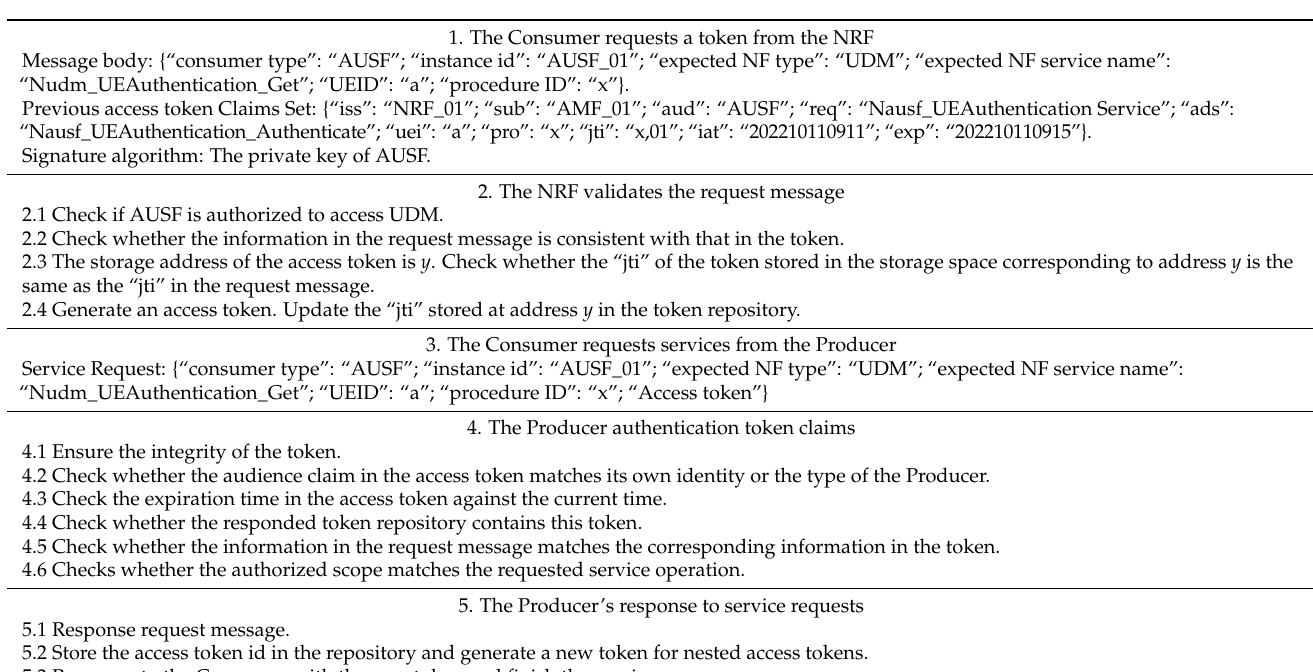
Table 6. The proocessing flows of the improved NF service access